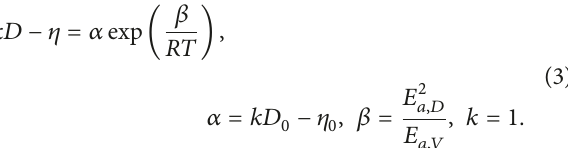
Figure 3: Temperature dependence of the ratio of correlation length and viscosity of Cu-Sn alloys (the lines are fitted by a linear